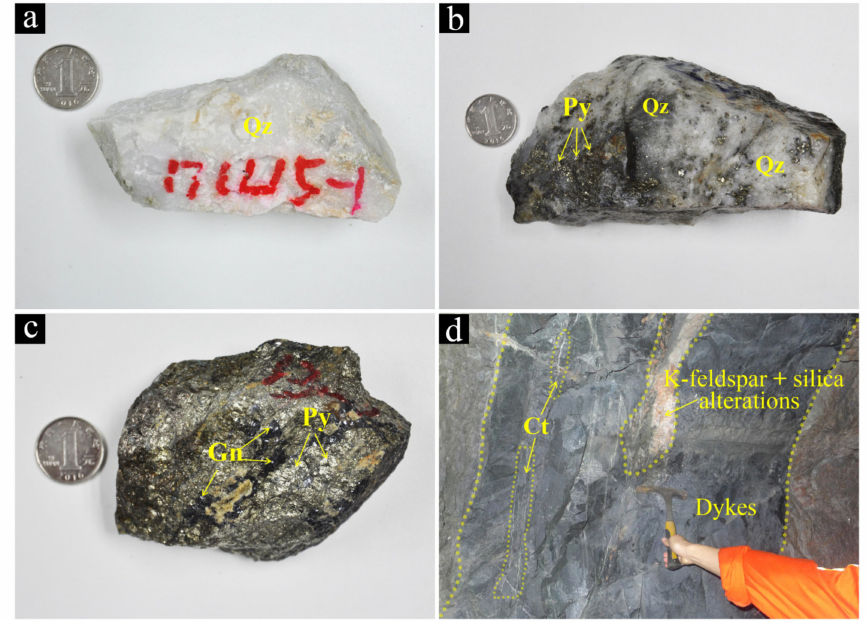
Figure 4. The ores and the veins in di ff erent stages of mineralization at the Linglong goldfield. ( a ) A hand specimen of V1with milky white quartz; ( b ) A hand specimen of V2 with quartz in white-gray color and poor transparency; ( c ) A hand specimen of V3 appearance of base-metal sulfides with golden color. ( d ) A tunnel picture of V4 in dykes and overprinted by potassic and silicic alterations. Qz: quartz, Py: pyrite, Ct: calcite, Gn: